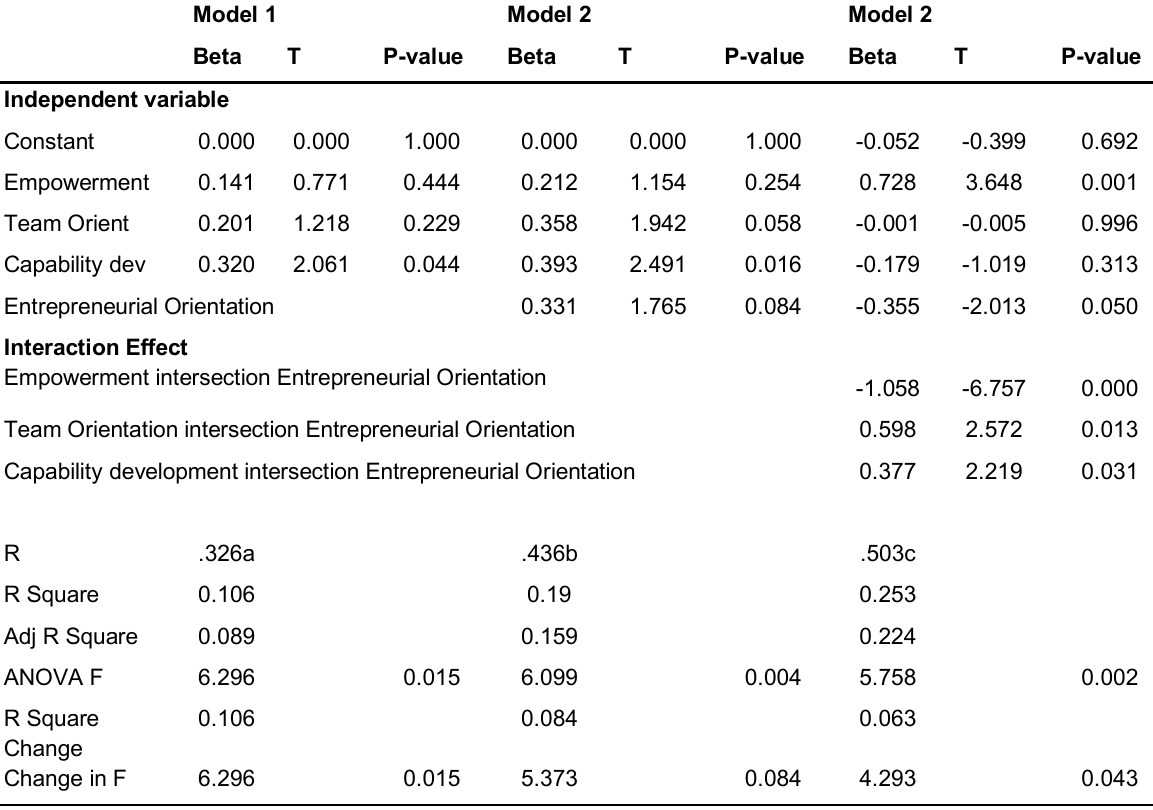
Table 6: Moderated Multiple